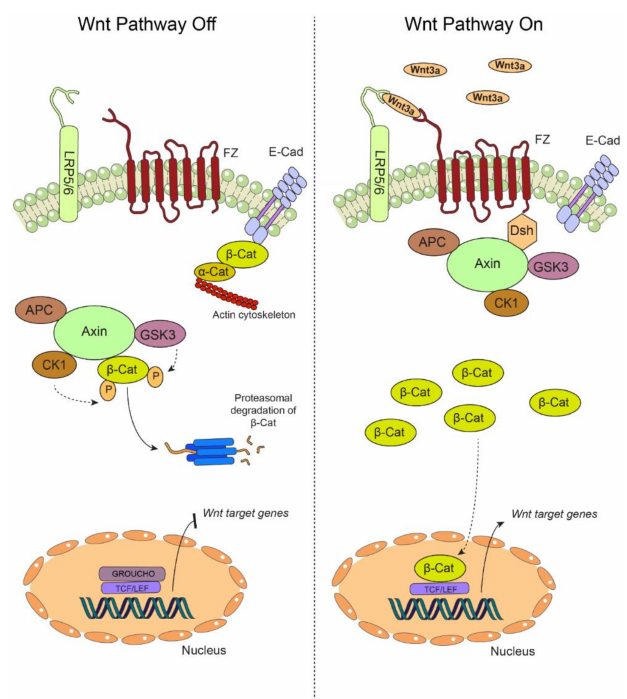
Figure 1. The canonical Wnt pathway. ( Left ) In the absence of extracellular Wnt ligands, the transmembrane receptors Frizzled (FZ) and the coreceptors LDL (low-density lipoprotein) receptor related protein 5 / 6 (LRP 5 / 6) are unable to associate at the plasma membrane, yielding an “o ff ” state of the pathway. During this o ff state, β -catenin ( β -Cat) is mainly found at cell-cell adhesion complexes, bridging together the intercellular adhesion molecule E-Cadherin (E-cad) and the actin cytoskeleton via interaction with α -catenin ( α -Cat). In the cytoplasm, β -catenin is rapidly targeted for proteasomal degradation by the so-called “destruction complex”, which is composed by adenomatous polyposis coli (APC), axin, casein kinase 1 (CK1) and glycogen synthase kinase 3 β (GSK3 β ). The targeting of β -catenin for degradation is based on sequential phosphorylation by CK1 and GSK3 β . In these conditions, β -catenin cannot translocate to the nucleus, and the transcription of the target genes is repressed by GROUCHO, which is bound to the TCF / LEF promoters. ( Right ) Secreted Wnt ligands, such as Wnt3a, are recognized by both FZ and LRP5 / 6, switching “on” the pathway. The destruction complex is then recruited to the plasma membrane via interaction with the FZ receptor, allowing the cytoplasmic accumulation of β -catenin, which is now available for translocation to the nucleus, where it binds the TCF / LEF promoter by displacing GROUCHO, allowing the transcription of Wnt target genes. Particularly, in oral carcinogenesis, this pathway is “switched on” by the increased secretion of Wnt3a, stabilization of β -catenin and the expression of target genes such as cyclin D1 and survivin (see main text for